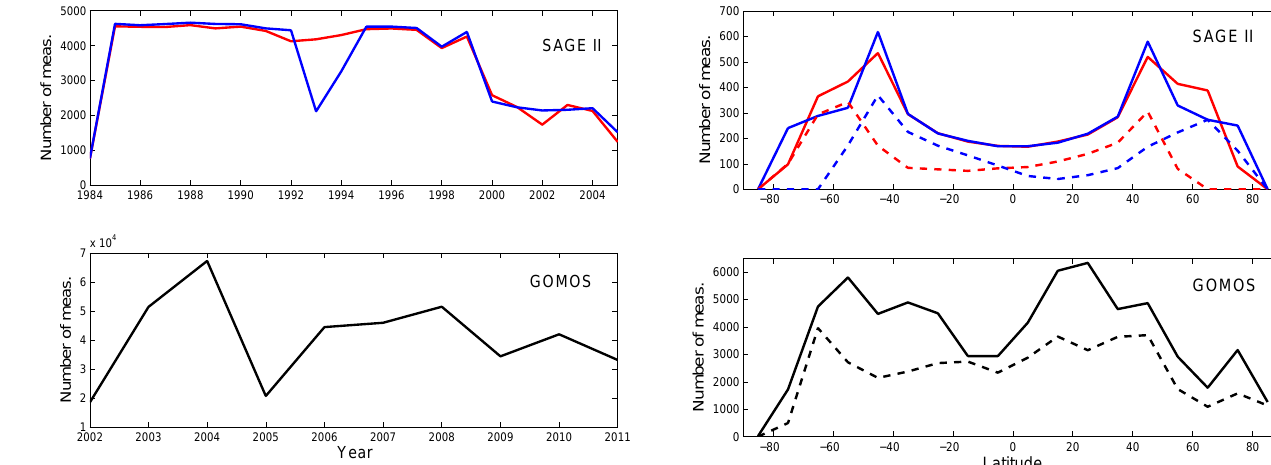
Fig. 2. Latitude distributions of SAGE II (top) and GOMOS (bot- tom) measurements. Notation: Solid and dashed red: SAGE II sun- rise for 1985 and 2004, solid and dashed blue: SAGE II sunset for 1985 and 2004, solid and dashed black: GOMOS for 2004 and